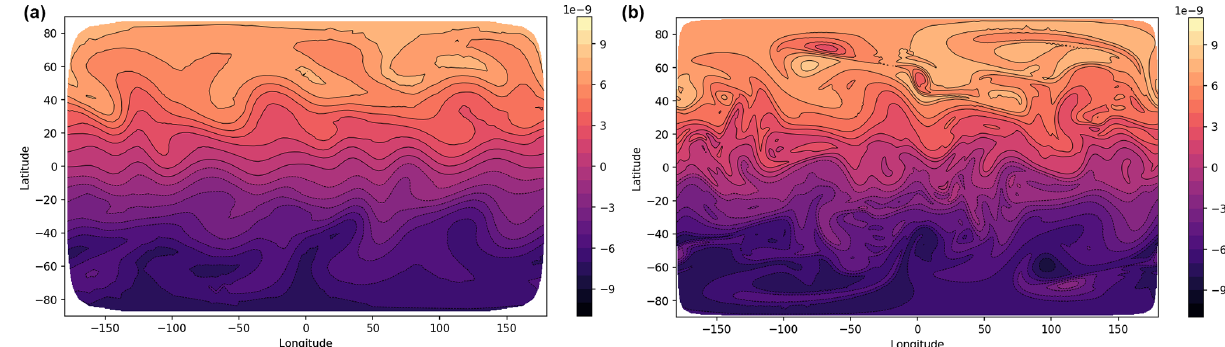
Figure 10. The potential vorticity q for the vortices test case after 15d for the C24 resolution (a) and the C96 resolution (b)